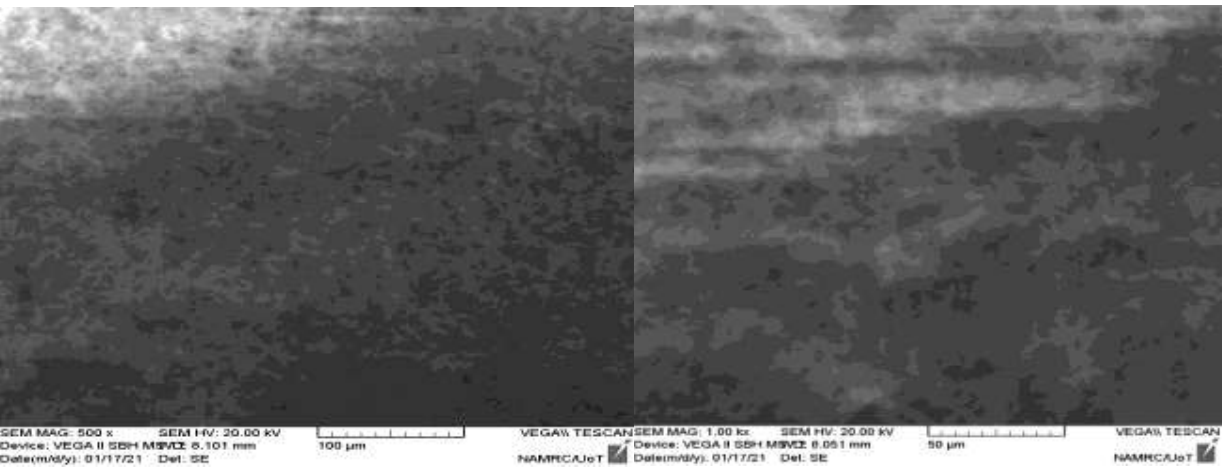
Figure 2: SEM topography of HSLA steel with Zn coating at different magnifications.